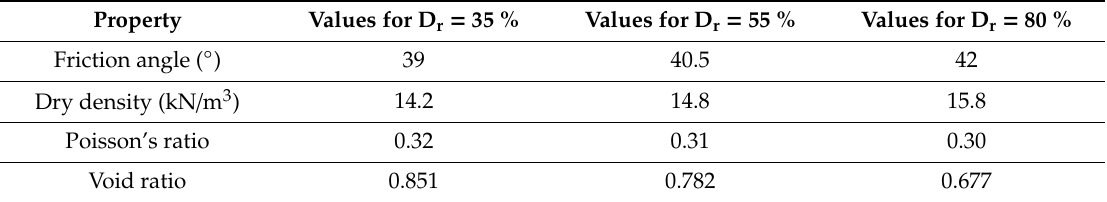
Table 4. Input properties of model soil for parametric study.